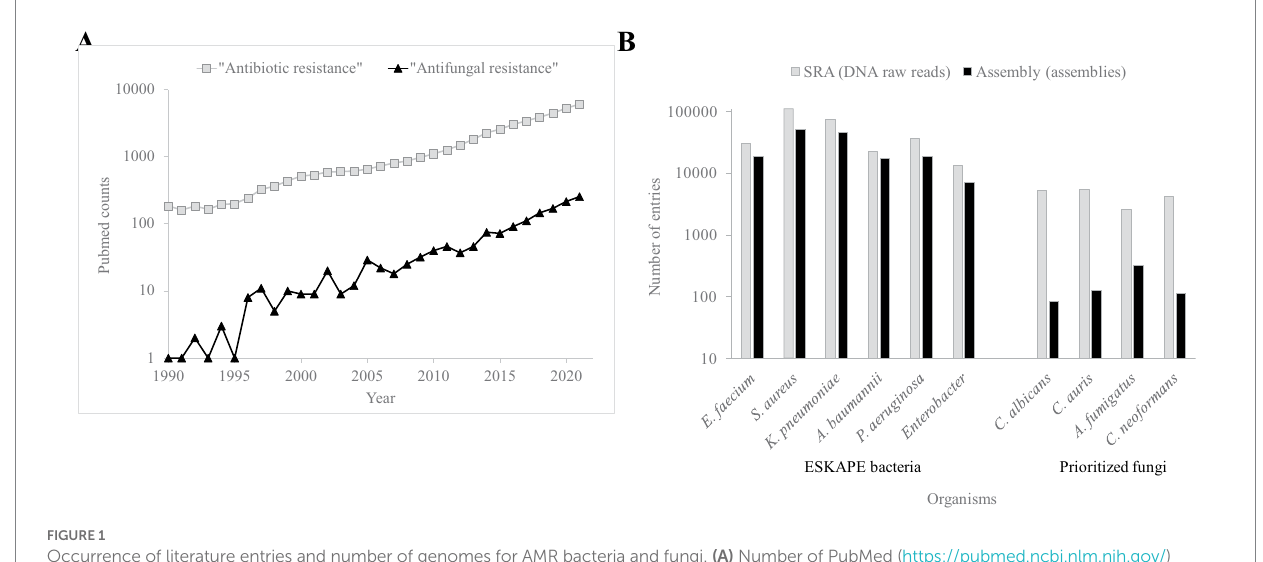
FIGURE 1 Occurrence of literature entries and number of genomes for AMR bacteria and fungi. (A) Number of PubMed (https://pubmed.ncbi.nlm.nih.gov/) counts during the 1990–2021 period using the “Antibiotic resistance” and “Antifungal resistance” search terms. (B) Number of entries concerning DNA reads and assembled genomes for the principal AMR bacteria and fungi in the SRA (https://www.ncbi.nlm.nih.gov/sra) and Assembly (https://www. ncbi.nlm.nih.gov/assembly) NCBI databases,